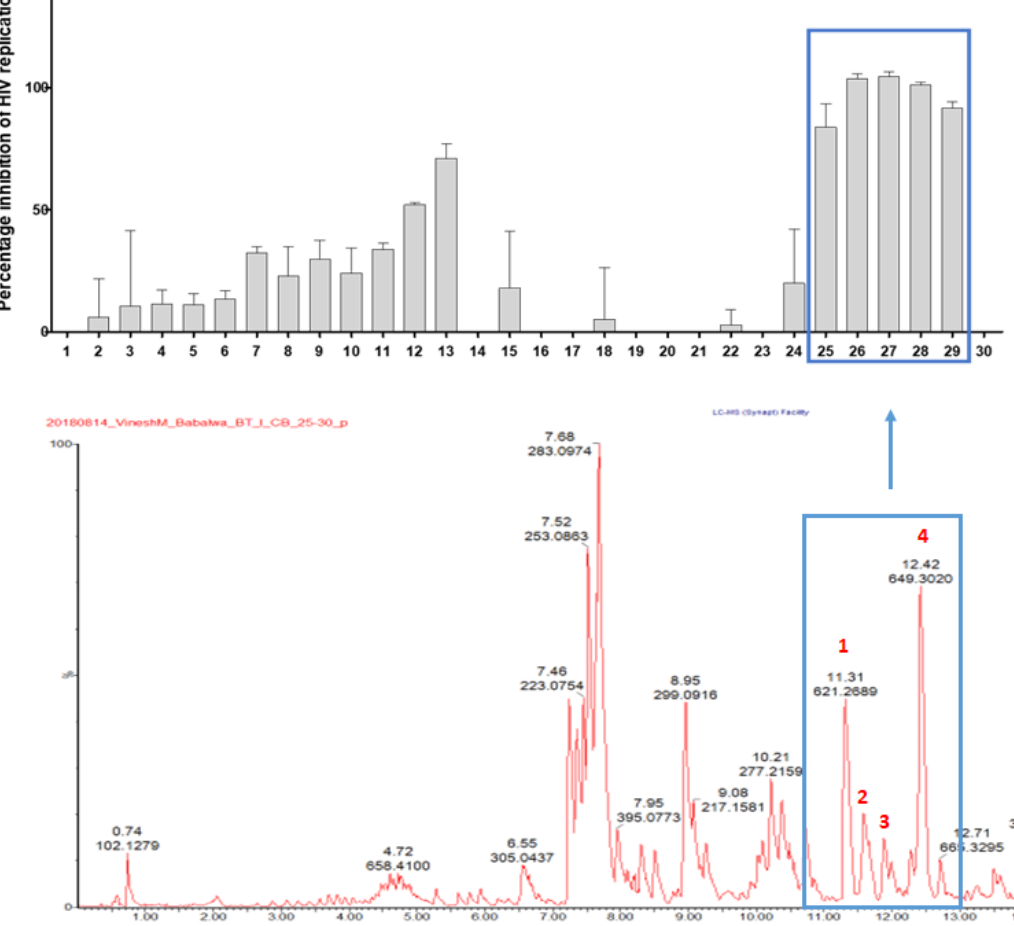
Figure 2. Anti-HIV replication activity of microfractions at 2.5 µg/mL, as measured using the deCIPhR in vitro assay, with corresponding UPLC-QTOF-MS data of the combined microfractions. Peaks 1-4 corresponded to isolated daphnane diterpenoids.